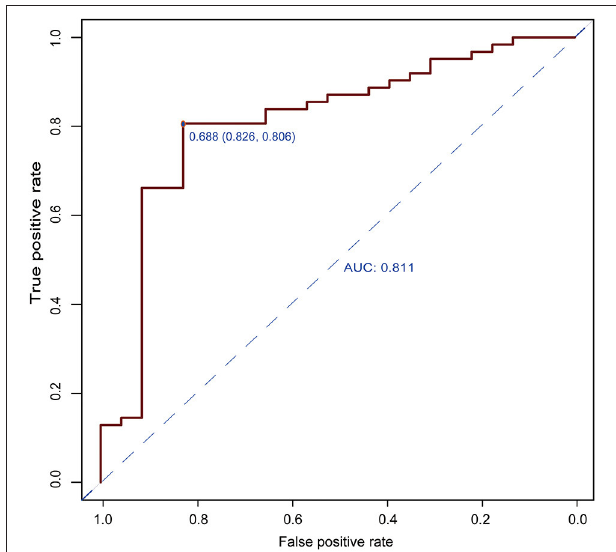
FIGURE 2 | Receiver operating characteristic (ROC) curves of the predictive model. The area under the ROC curve (AUC) from the model was 0.811, the cut-off value for the prediction score at the optimum point was 0.688, the sensitivity was 82.6%, and the specificity was